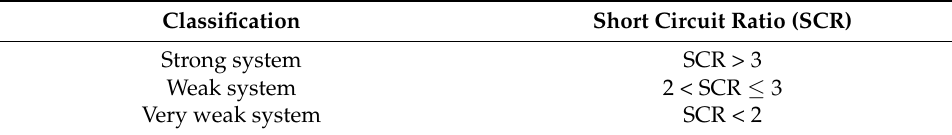
Table 1. Short circuit ratio and AC system